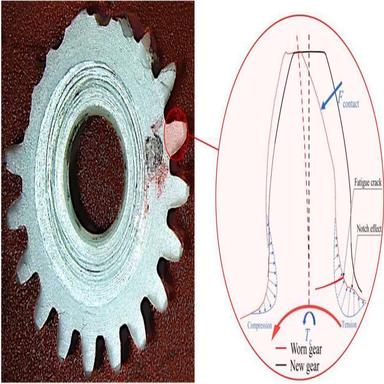
Tooth failure zone: 2D tooth profile.